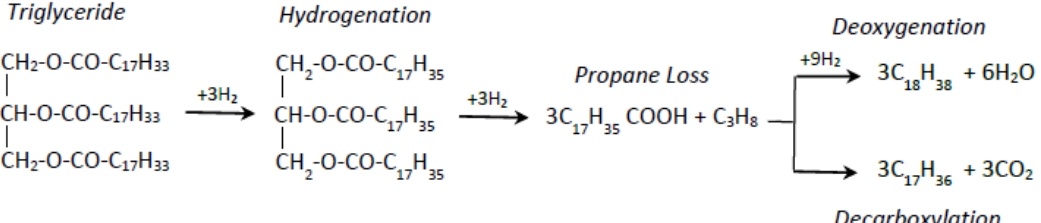
Figure 2. Renewable oil deoxygenation reaction pathways [30].